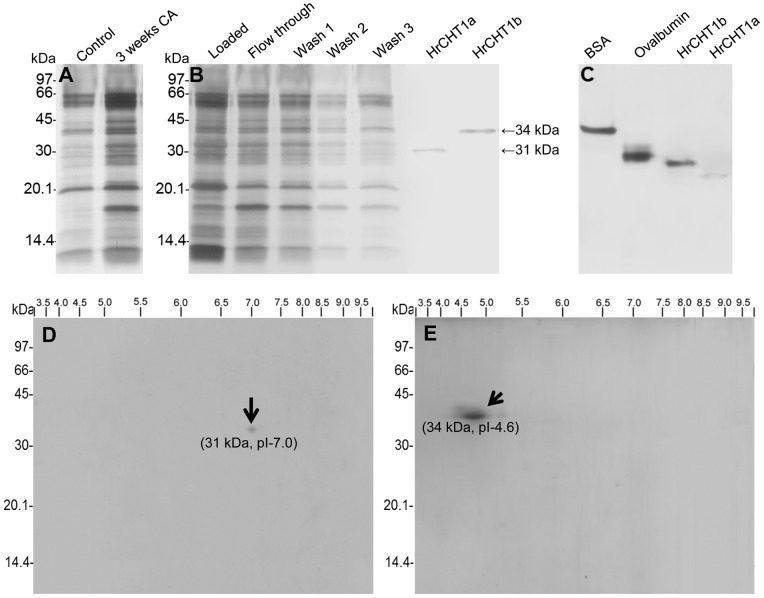
Purification of HrCHT1a and HrCHT1b.(A) Silver stained 15% SDS-PAGE gel showing apoplastic proteins isolated from non-acclimated and 3 weeks cold acclimated seedlings. (B) SDS-PAGE and (C) 10% native gel showing purified class I chitinase from 3 weeks cold acclimated apoplastic extracts using chitin affinity chromatography. (D) Two dimensional gel electrophoresis of HrCHT1a and HrCHT1b (E). Purified HrCHT1a and HrCHT1b (70 µg) were loaded on 3–10 non-linear IPG strips and subjected to iso-electric focusing. After IEF, proteins were resolved on 15% SDS-PAGE for the second dimension.